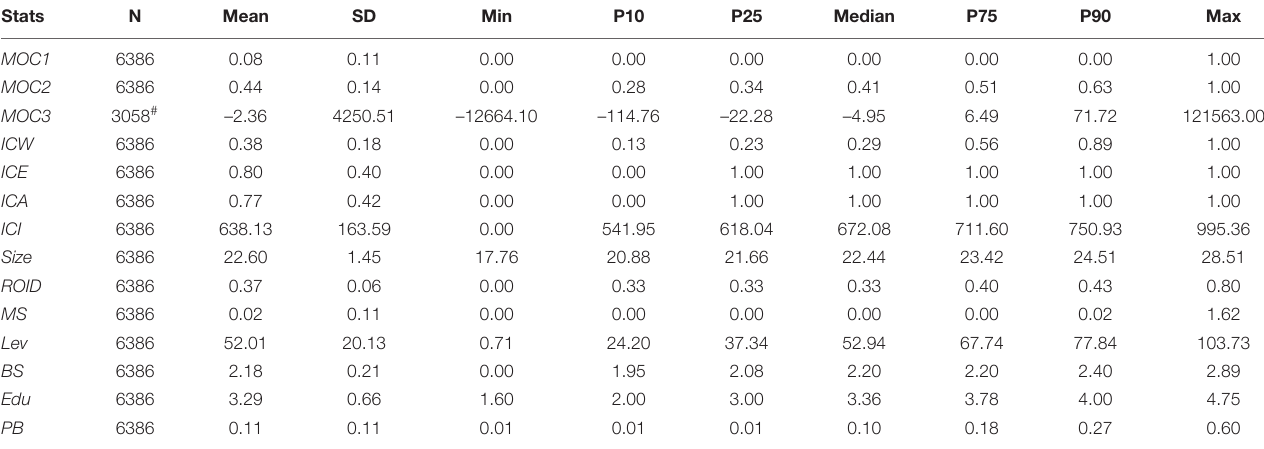
TABLE 2 | Descriptive statistics